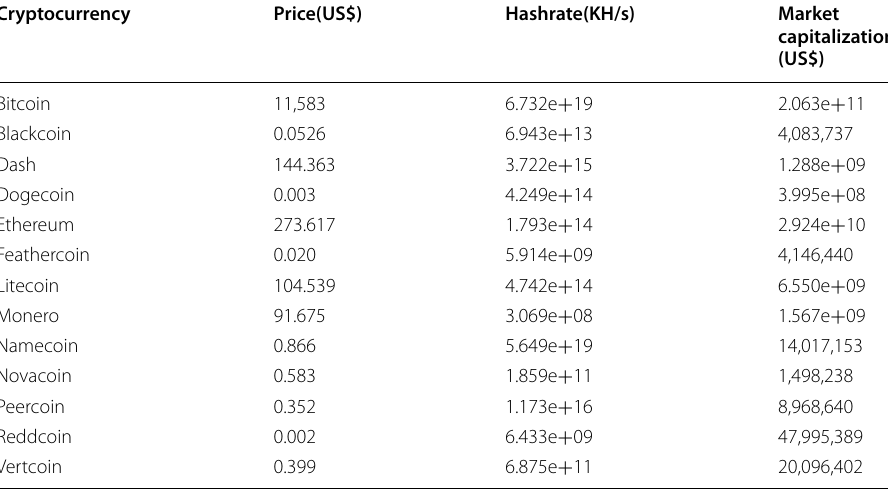
The price, network hashrate, and market capitalization of 13 cryptocurrencies on July 12, 2019. Price and hashrate take the average over the full time span